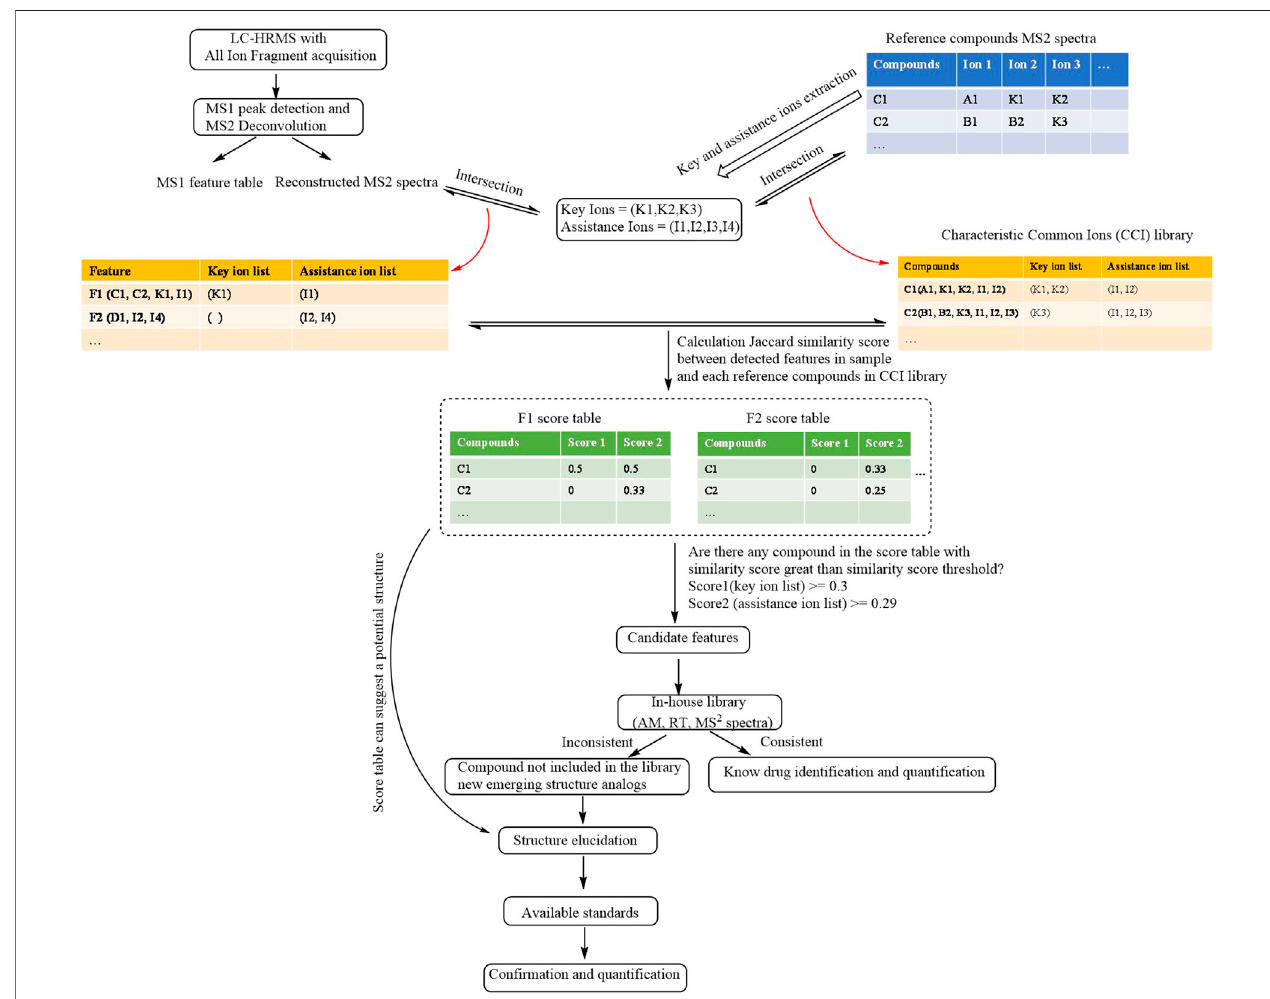
FIGURE 1 | Schematic work fl ow of